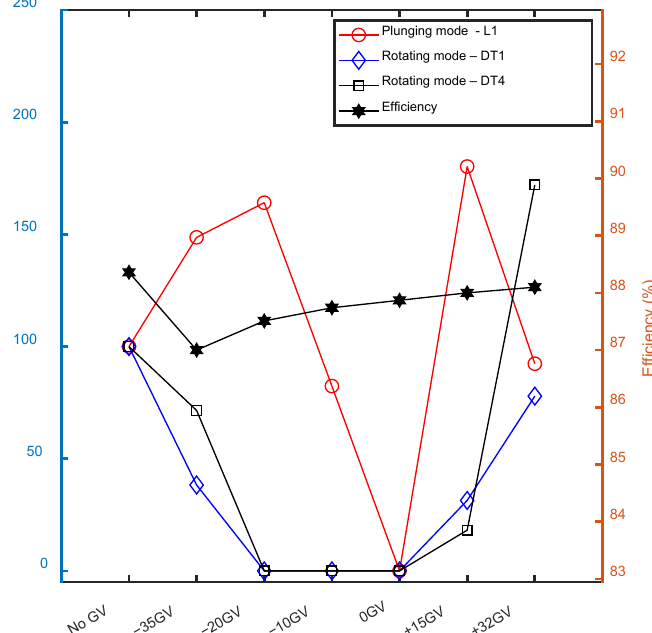
Figure 10. Hydraulic efficiency compared against decomposed RVR pressure amplitudes at PL1 without and with the GV systems at different upper hydrofoil angles.